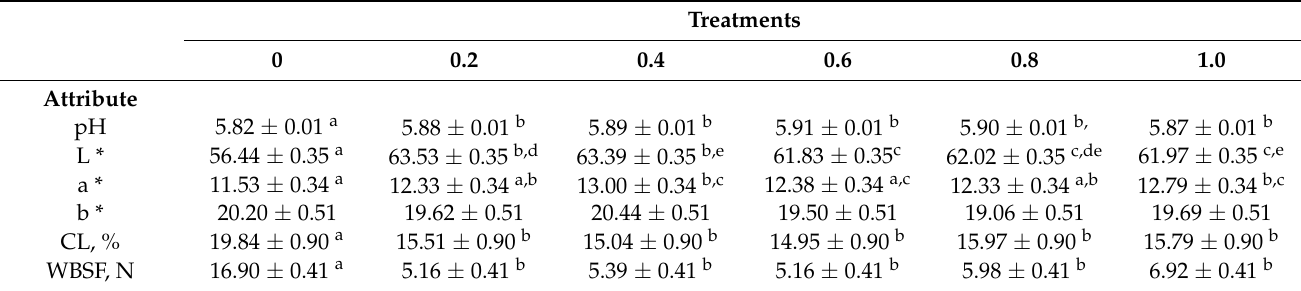
Table 1. pH value (pH), color parameters (L * a * b *), cooking loss (CL), and Warner–Bratzler shear force (WBSF) of intact chicken breast meat and restructured chicken breast meat (RCM) supplemented with 0.2%, 0.4%, 0.6%, 0.8%, and 1% of transglutaminase enzyme (LSM ± SE).